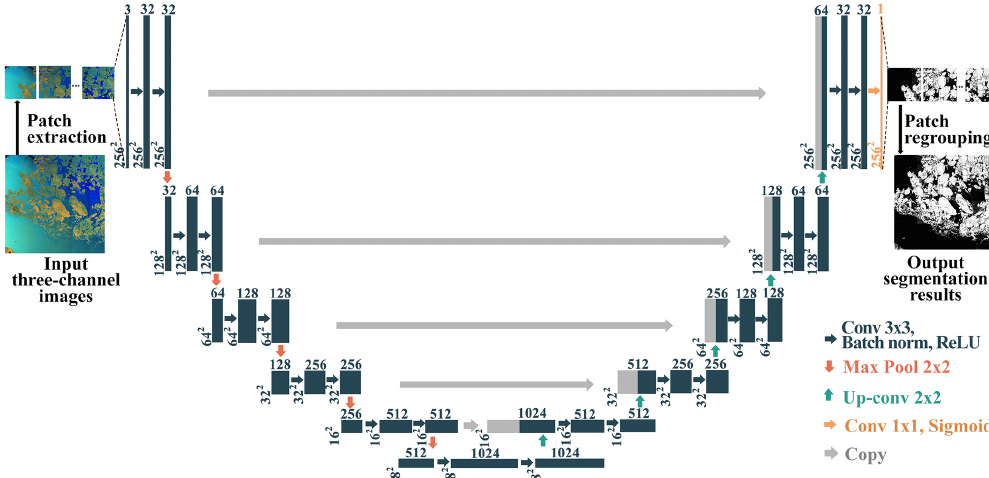
Figure 7. The overall architecture of the proposed sea ice segmentation model for the S1 EW data based on the U-Net deep learning algorithm.